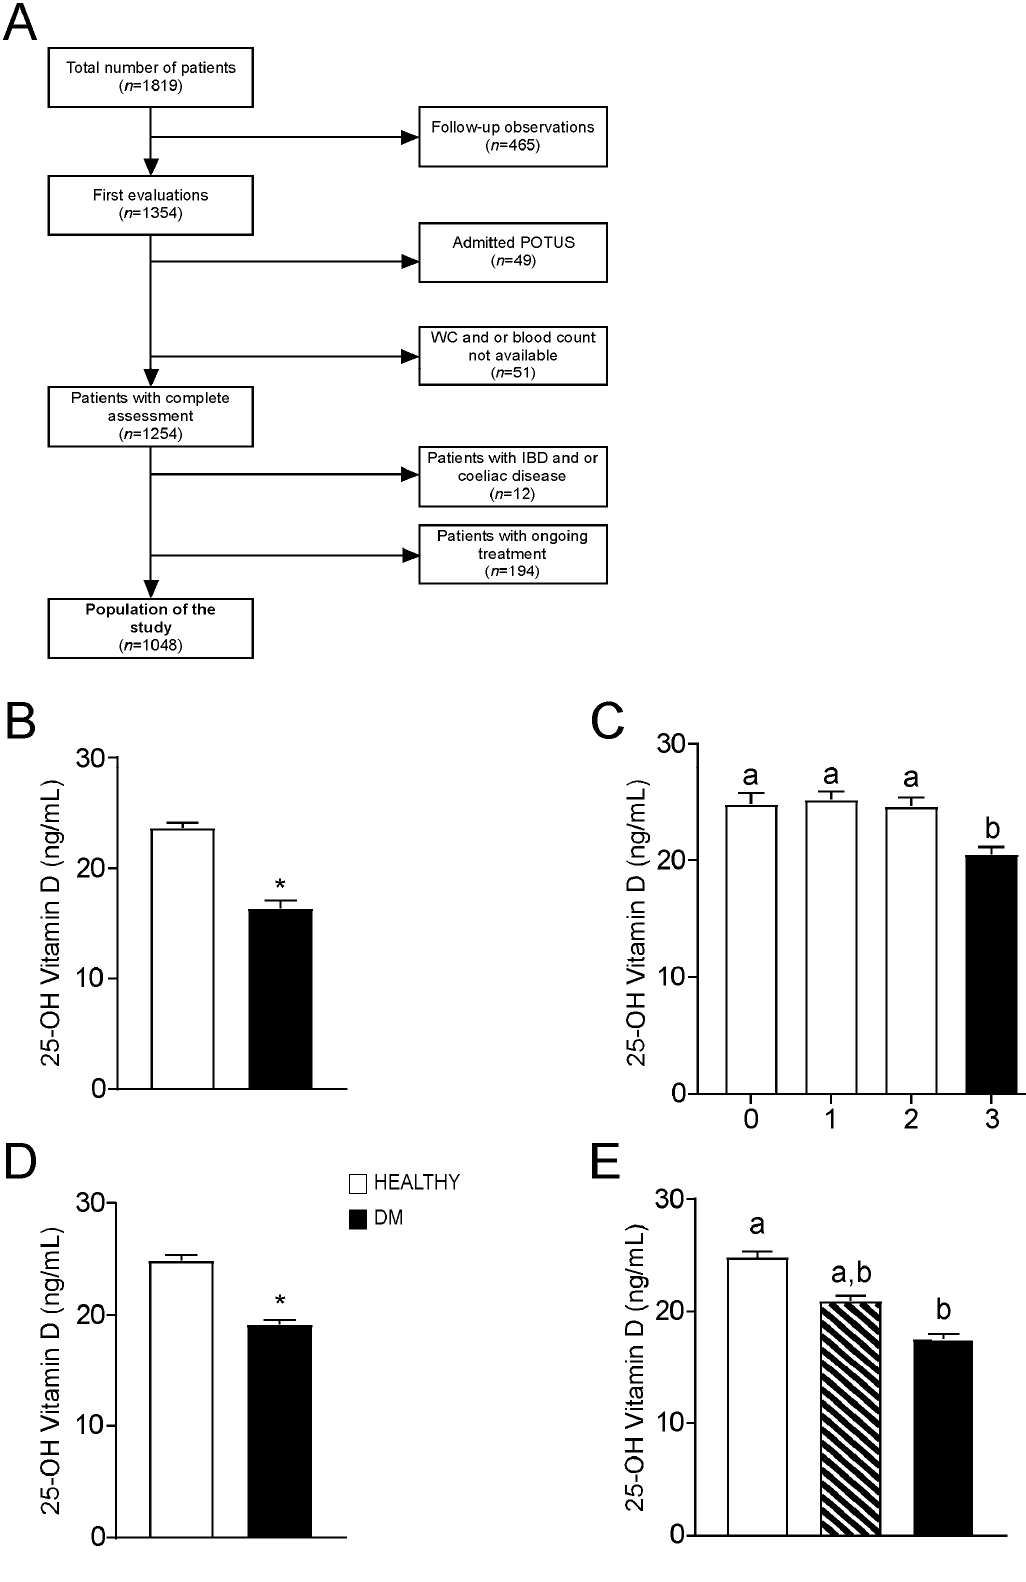
Figure 1. Flowchart of study population and 25-OH vitamin D levels in different subgroups. ( A ) Flowchart of the study population. ( B ) Comparison of 25-OH vitamin D levels in the entire study population. Subjects categorized based on Metabolic Syndrome (MetS) diagnosis; non-metabolic (MetS NO) subjects n = 466, MetS (MetS YES) patients n = 582. ( C ) Comparison of 25-OH vitamin